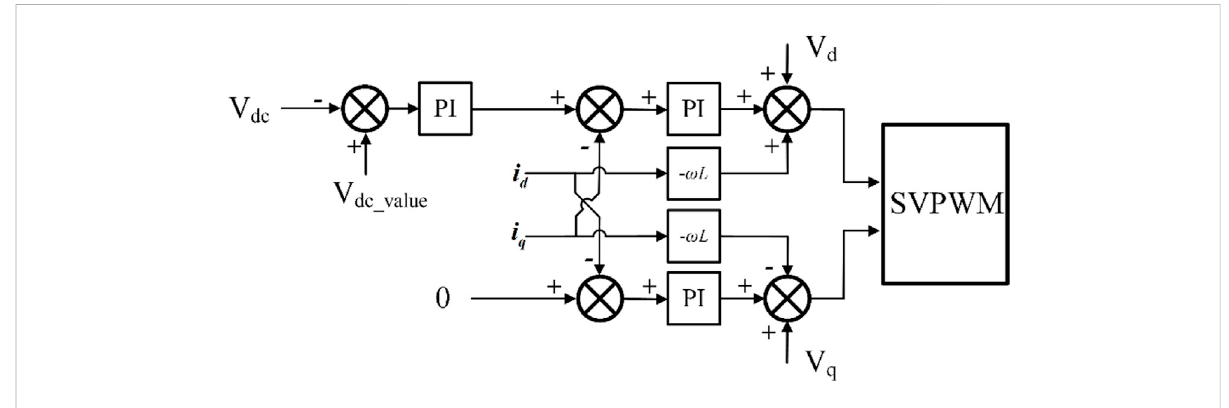
FIGURE 5 Schematic diagram of V dc Q control